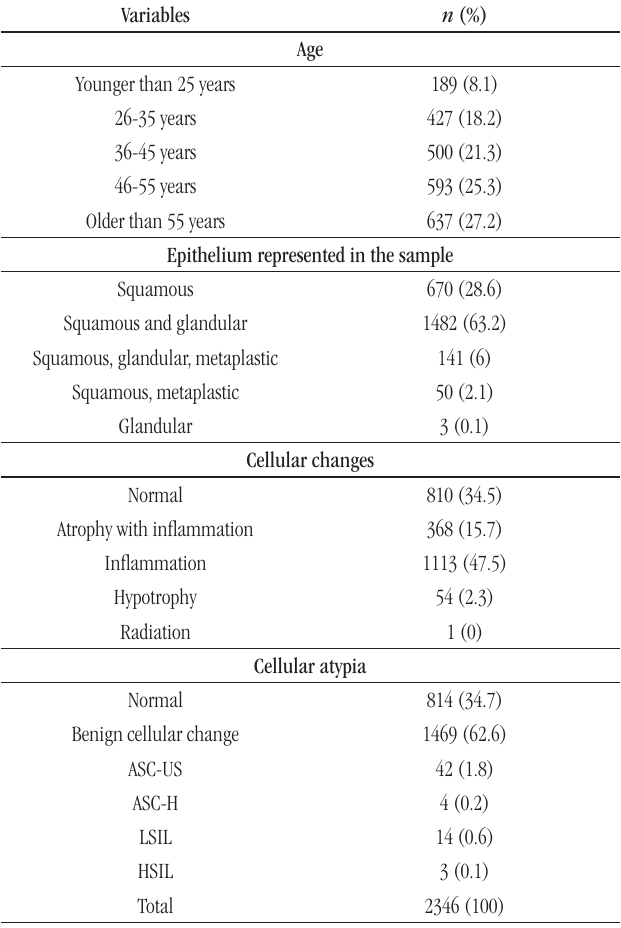
taBLE 1 − Age and descriptive diagnosis of cytopathological examination